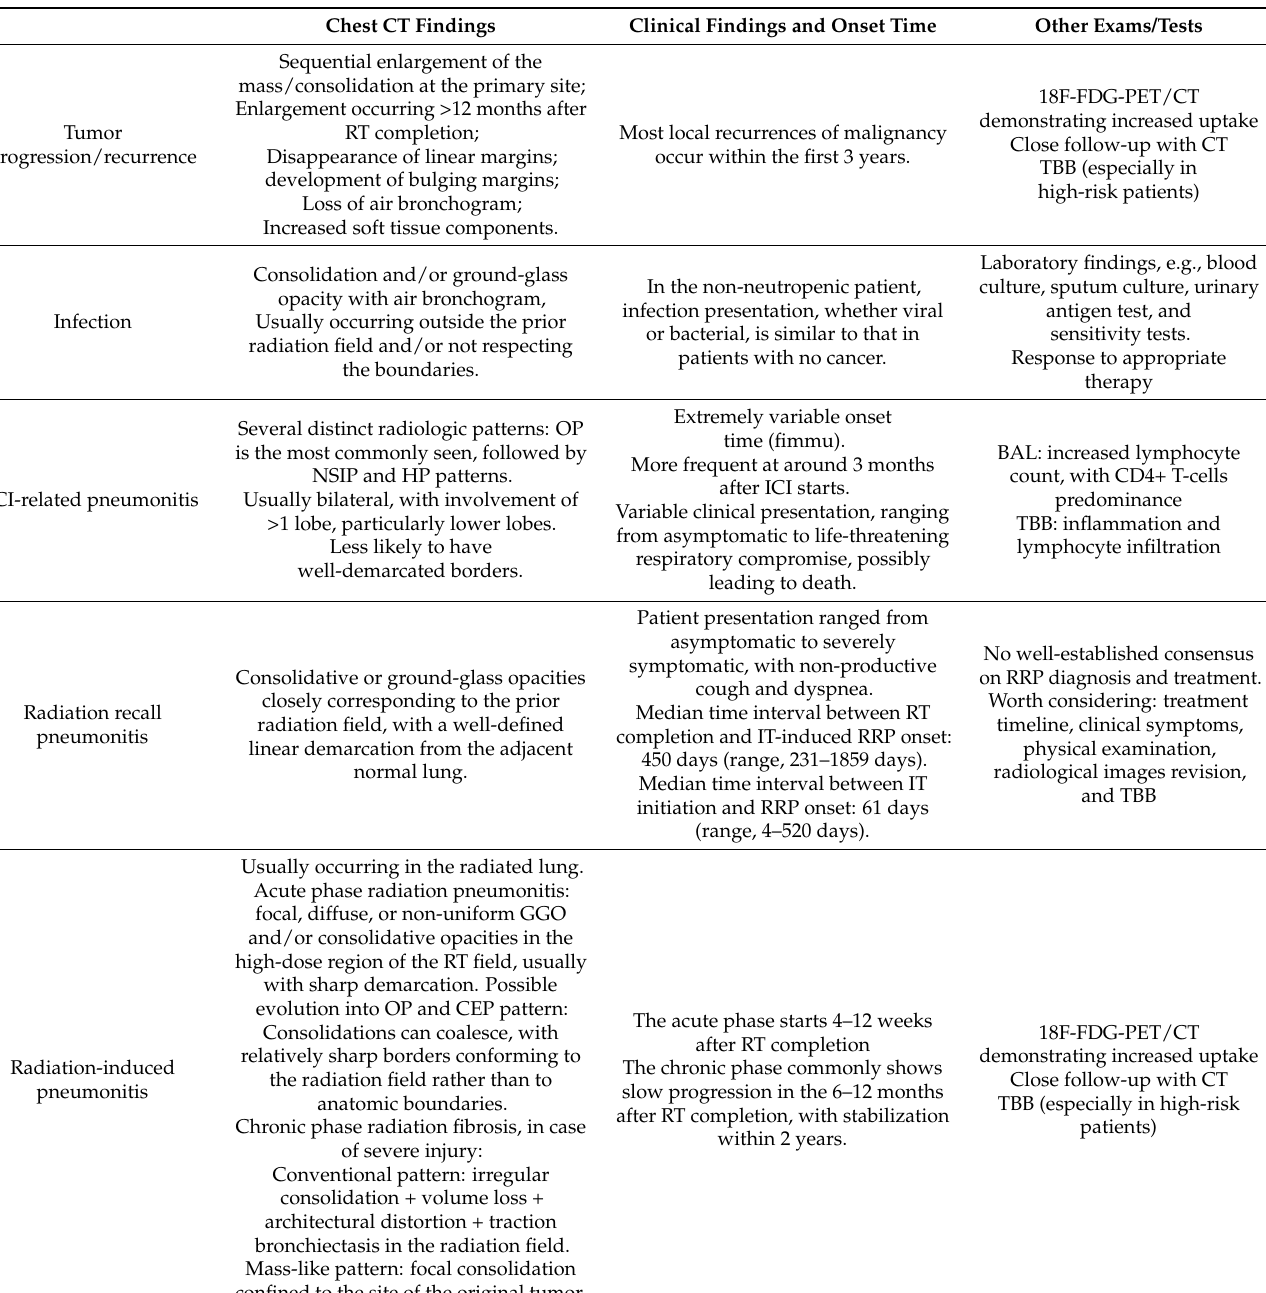
Table 1. Main chest CT findings, clinical findings, and suggested additional exams for differentiating radiation recall pneumonitis from tumor progression/recurrence, infection, immune checkpoint inhibitor pneumonitis, and radiation-induced pneumonitis